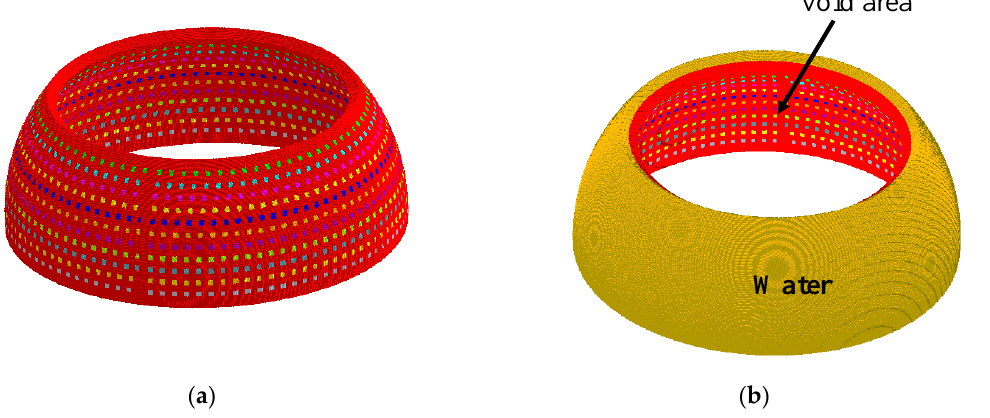
Figure 12. Finite element models of the SA: ( a ) aluminum base platform; and ( b ) array covered with a water layer.